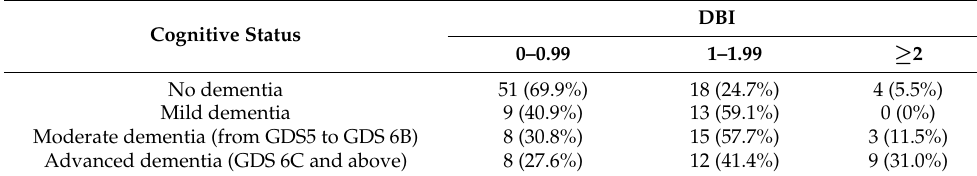
Table 4. Relation between cognitive status and degree of